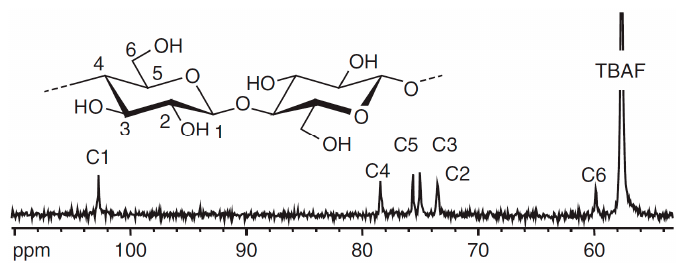
Figure 12. 13 C-NMR spectrum of unmodified cellulose dissolved in dimethyl sulfoxide-d 6 /TBAF · 3H 2 O, reprinted with permission from [16], Copyright (2012) Elsevier. DMSO/TBAF·3H 2 O was used for homogeneous derivatization of cellulose by transesterification employing vinyl esters of different carboxylic acids, resulting in cellulose esters with varying DS. Ciacco et al. employed sisal cellulose for reactions with acetic anhydride, stearic anhydride, vinyl